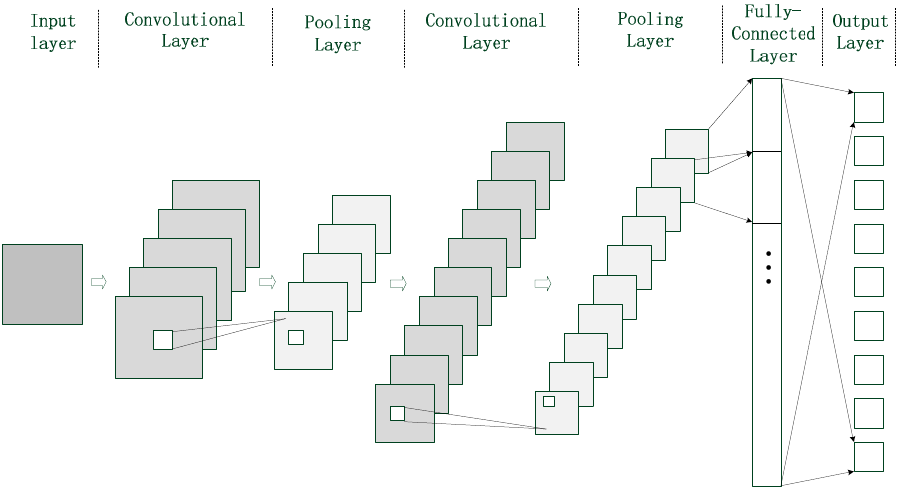
Figure 2. The typical structure of convolutional neural network (CNN).